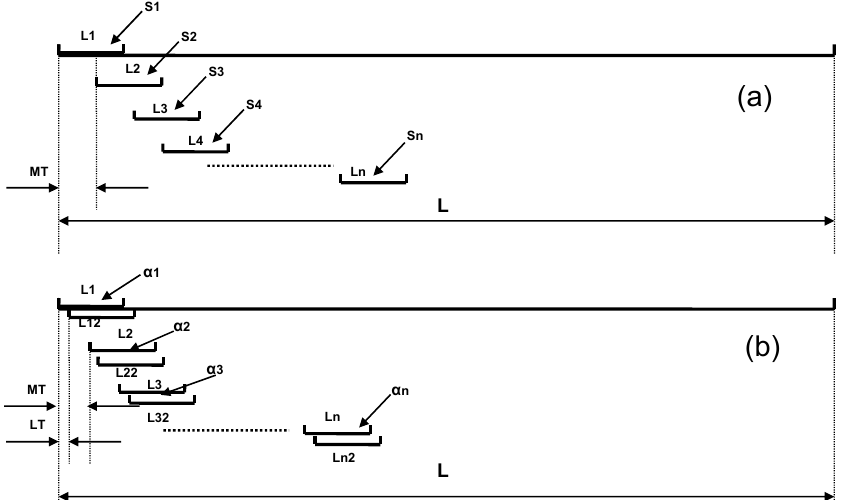
Figure 1. We calculated the variance and autocorrelation coefficient by sliding the window. ( a ) We calculated variance by sliding the window, L1, L2, L3, …, Ln denote windows of the same length(ML), S1, S2, S3, …, Sn represent the variances of the corresponding windows,L is the total length of the sequence, and MT is the sliding step; ( b ) we calculated the autocorrelation coefficient by sliding the window, L1(L12), L2(L22), L3(L32), …, Ln(Ln2)represent windows of the same length, α 1 denotes the autocorrelation coefficients of L1 and the L12, α 2 denotes the autocorrelation coefficient of the L2, while L22, the α n refer to the autocorrelation coefficients of the Ln and Ln2, LT represents the lag time, and L, ML and MT have the same meaning as those in ( a